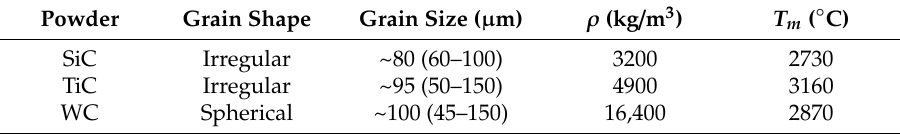
Table 3. Main physical properties of powders used in the laser dispersing studies. Powder